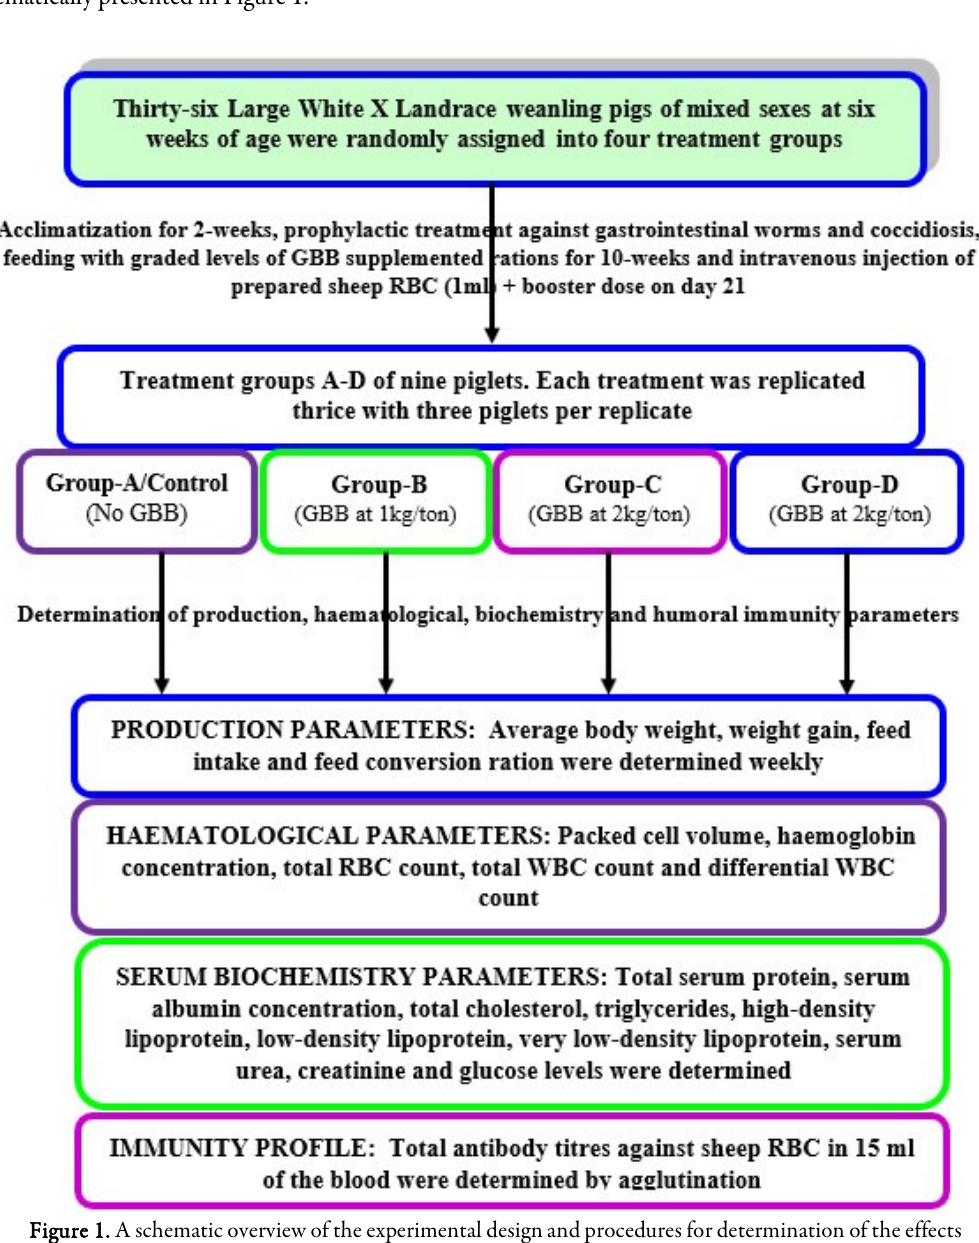
Figure 1. A schematic overview of the experimental design and procedures for determination of the effects of gut balance booster on production, haematological, biochemistry and immunity parameters of weanling pigs in Nigeria GBB = Gut balance booster, RBC = Red blood cell, WBC = White blood